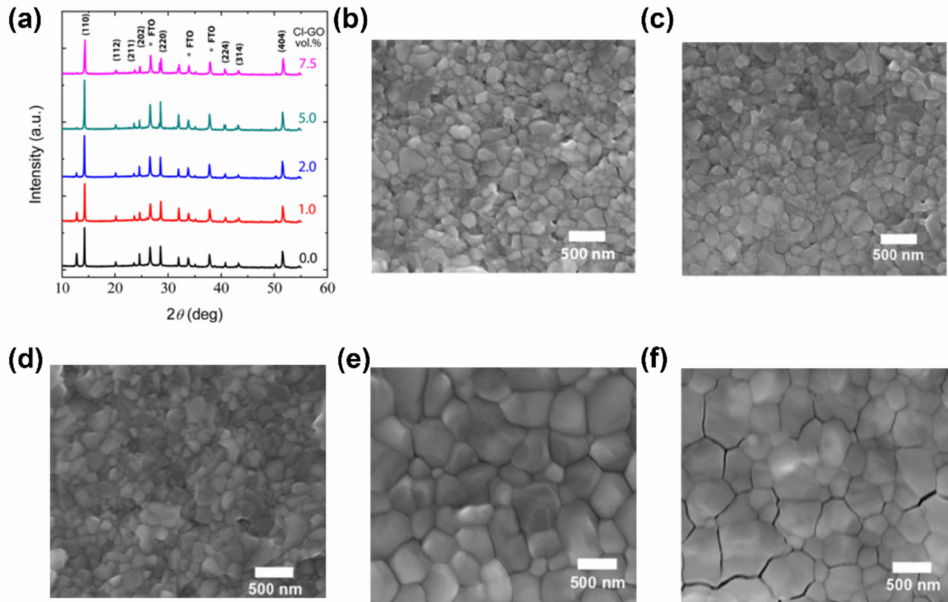
Figure 5. ( a ) XRD patterns of perovskite films as a function of Cl–GO amounts. SEM images of perovskite films with different amounts of Cl–GO in the precursor solution: ( b ) pristine 0.0 vol%, ( c ) 1.0 vol%, ( d ) 2.0 vol%, ( e ) 5.0 vol%, and ( f ) 7.5 vol% Cl-GO. Data taken from ref. [85].